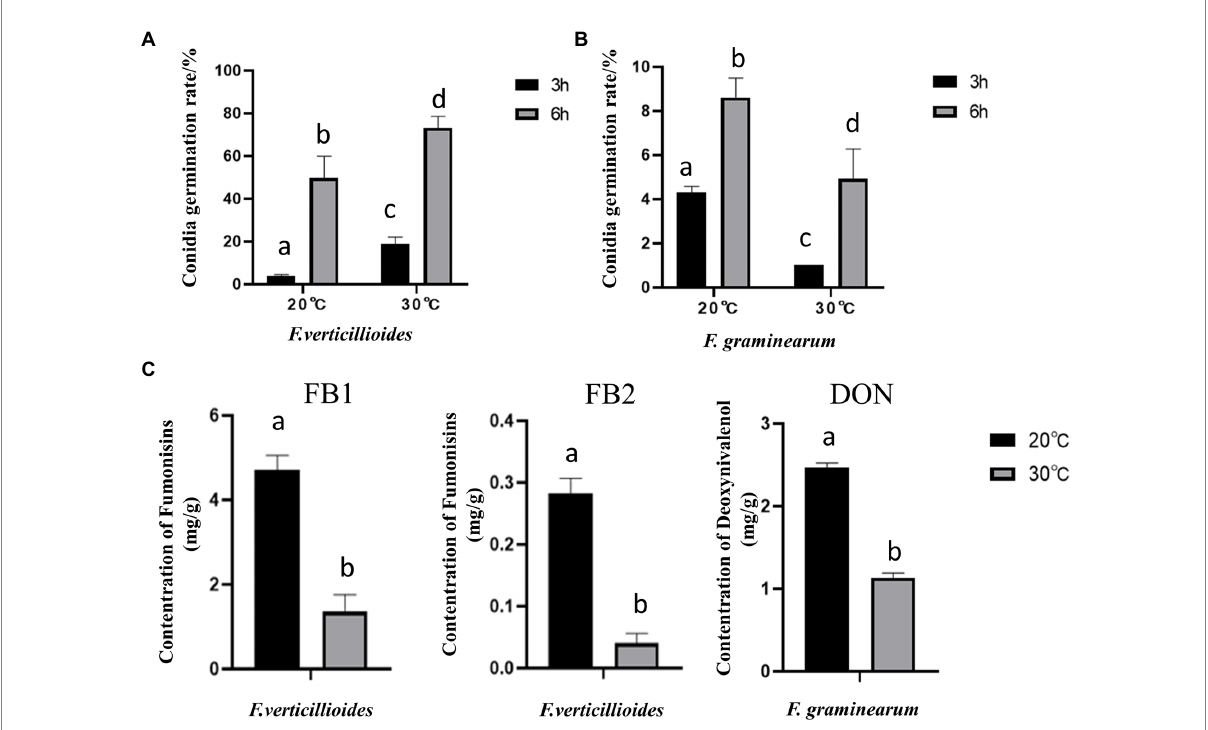
FIGURE 3 The effect of culturing temperature on conidial germination and mycotoxin production of F. verticillioides and F. graminearum . Conidial germination of F. verticillioides (A) , and F. graminearum (B) , under an oligotrophic condition. The conidia were inoculated on a water agar plate and cultured at 20 ° C and 30 ° C to determine the germination percentage; (C) the Fumonisins B1 (FB1) and Fumonisins B2 (FB2) content produced by F. verticillioides and the Deoxynivalenol (DON) content produced by F. graminearum under 20 and 30 ° C, respectively. Values are means, with standard error bars ( n = 3). Columns with non-matching letters indicate a significant difference at p <